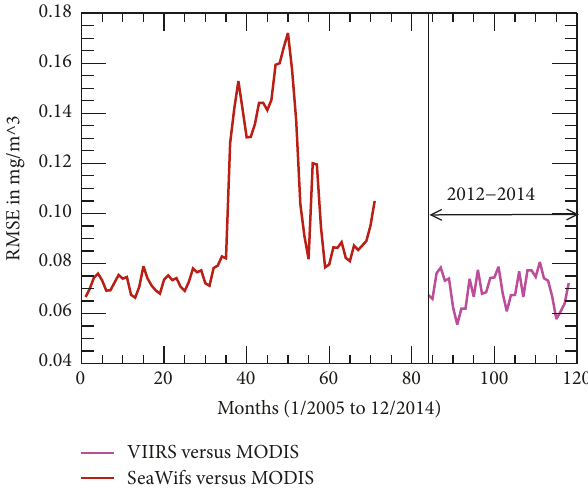
Figure 2: Correlation: MODIS versus VIIRS and MODIS versus SeaWiFS.